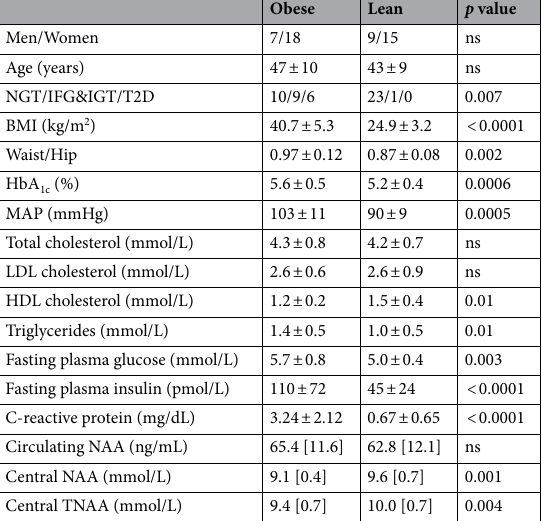
Table 2. Clinical characteristics of Dataset 2 . Entries are mean ± SD or median [IQR].